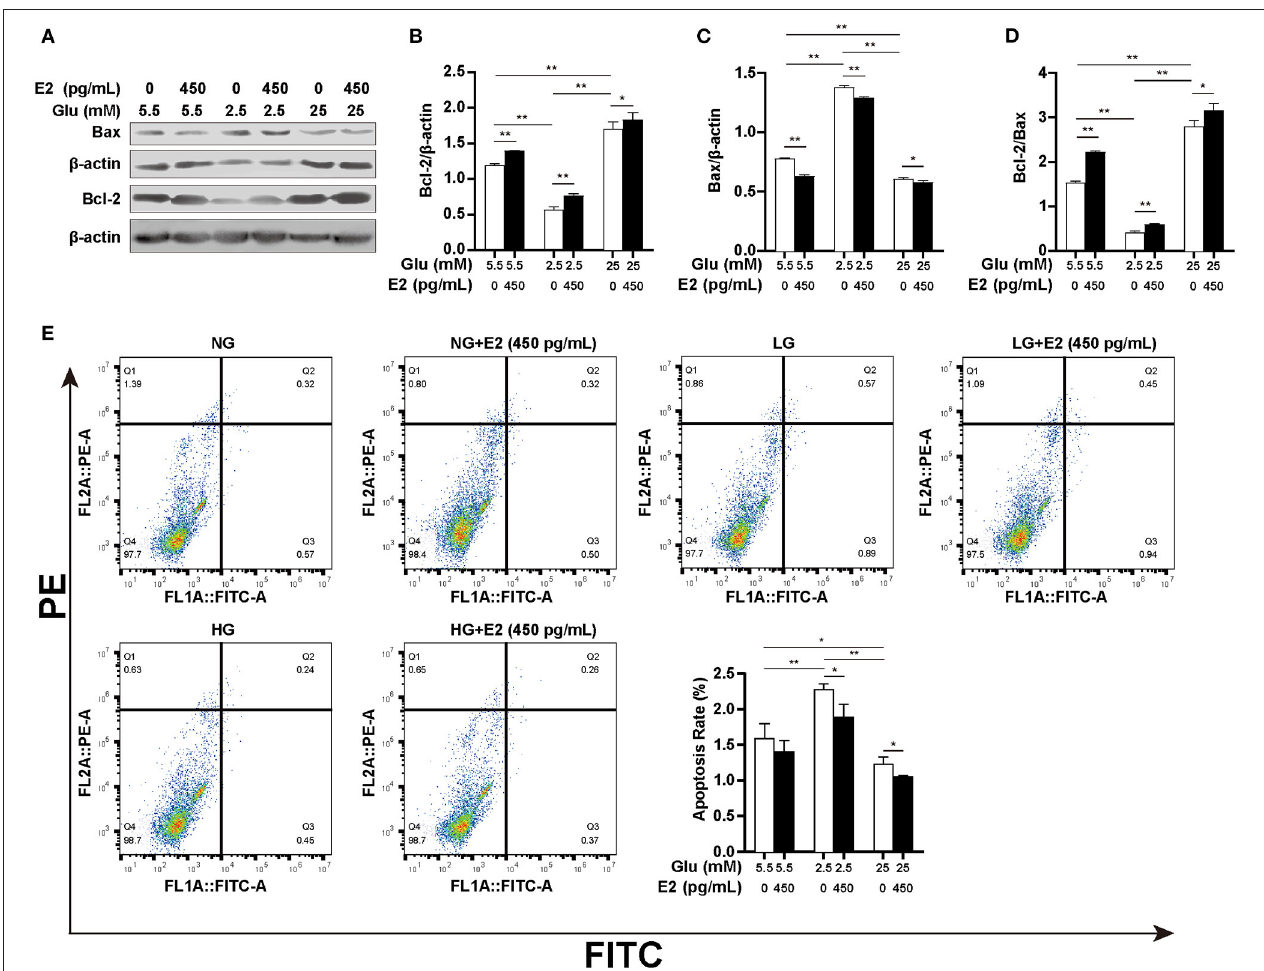
FIGURE 6 | E2 inhibits PMNs apoptosis. PMNs were treated with NG, NG + EH, LG, LG + EH, HG and HG + EH for 6h. (A–D) The expression of the apoptosis-related proteins Bax and Bcl-2 and the Bcl-2/Bax ratio were analyzed by WB. (E) Apoptosis rates in PMNs were assayed by flow cytometry. The results are shown as the mean ± SD ( n = 3). Differences were analyzed using the t -test. * P < 0.05, ** P <